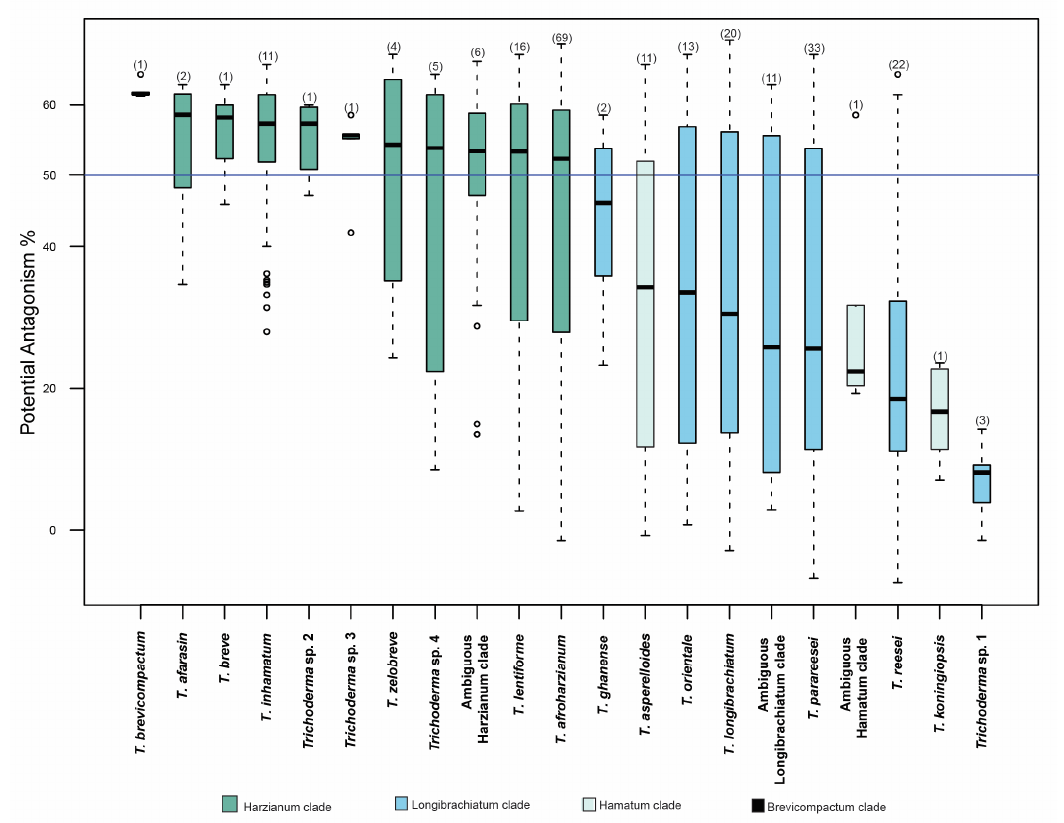
Figure 4. Boxplots displaying the potential antagonism of Trichoderma spp. evaluated in this study against M. roreri (strain numbers for each